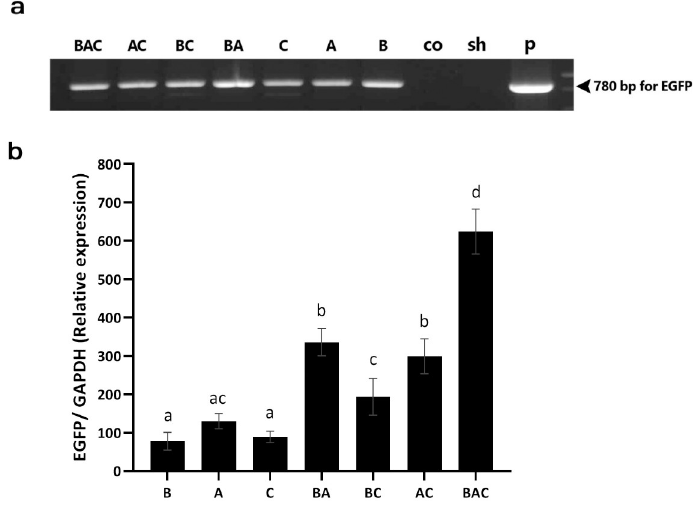
Fig 2. PCR screening of putative transgenic male founders. (a) Genomic PCR analysis of the semen of G 0 roosters. The EGFP reporter gene in the semen samples of G 0 roosters in all vector-injected groups was detected by PCR. DNA samples used as templates for PCR were as follows: Plasmid DNA (pWPXL) (P) as positive control, genomic DNA extracted from the semen of the seven vector-injected (left to right lanes, respectively), control (Co) and sham (Sh) groups. (b) Quantitative RT-PCR analysis of testis mRNA from G 0 chickens. Total mRNA was isolated from the testicular tissues of G 0 chickens and analyzed by RT-PCR. The data were normalized with the expression of chicken